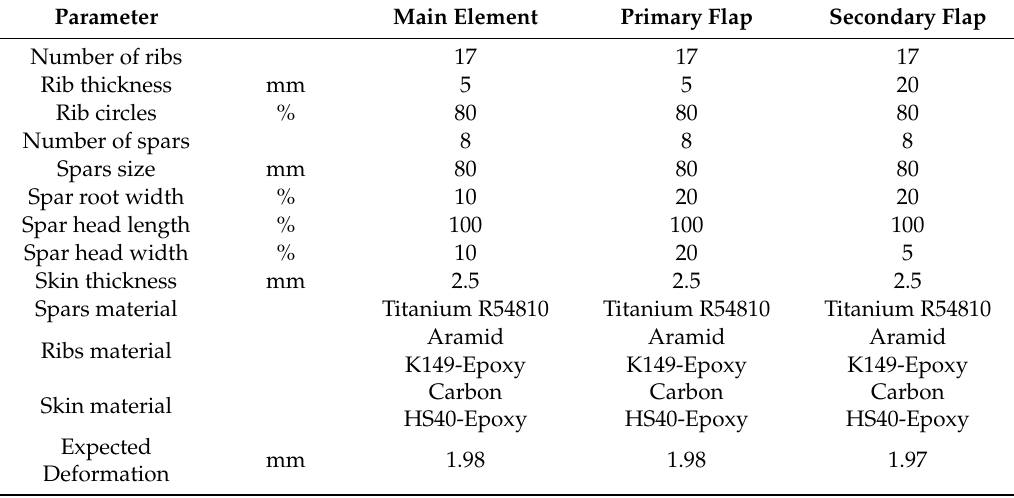
Table 9. Features of the structural elements of each wing, including